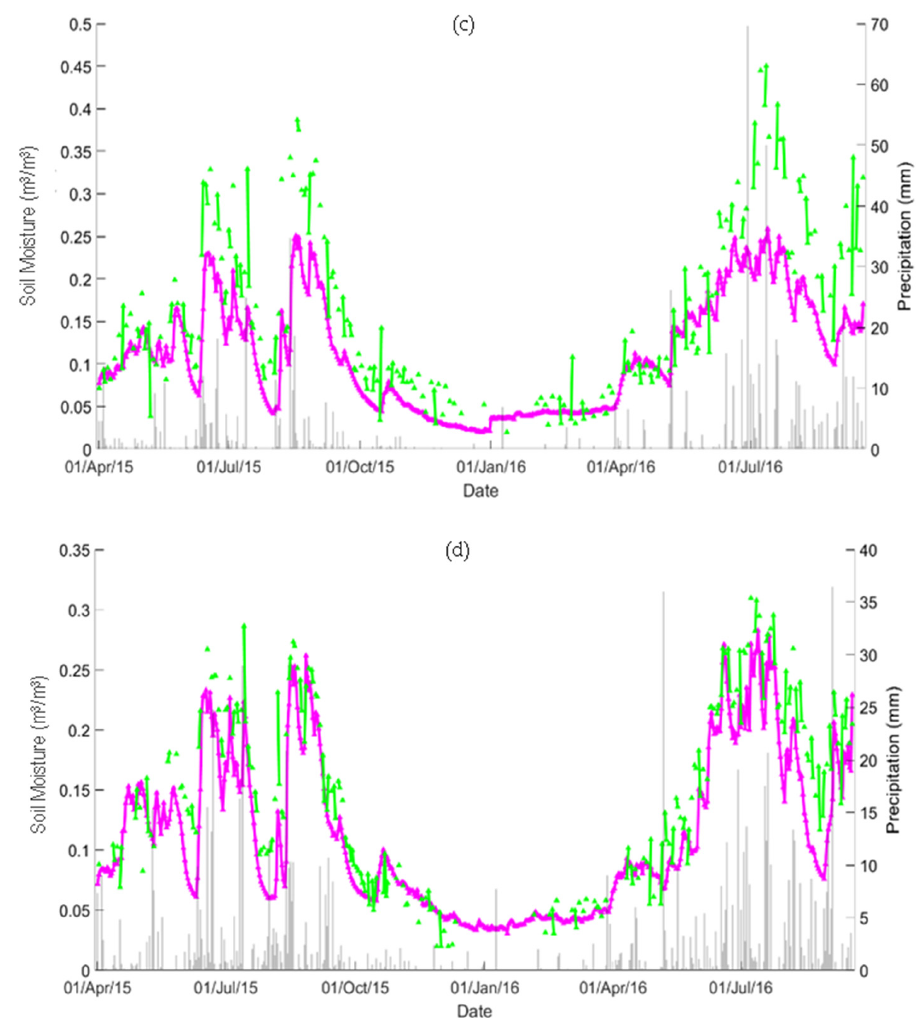
Figure 2. Temporal evaluation of station-averaged soil moisture (purple) and SPL3SMP_36km soil moisture (green): ( a ) Grid_2139, ( b ) Grid_2140, ( c ) Grid_2141, and ( d ) Grid_2142. The grey vertical lines represent